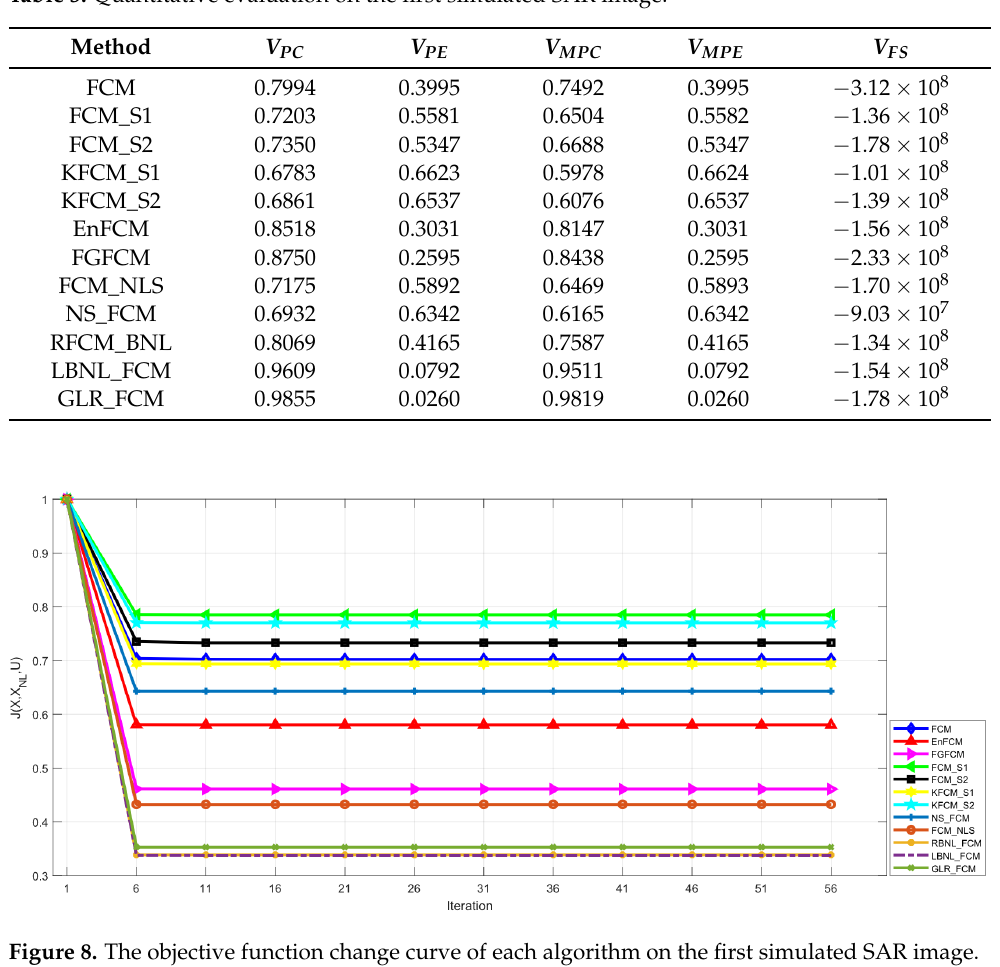
Table 3. Quantitative evaluation on the first simulated SAR image.